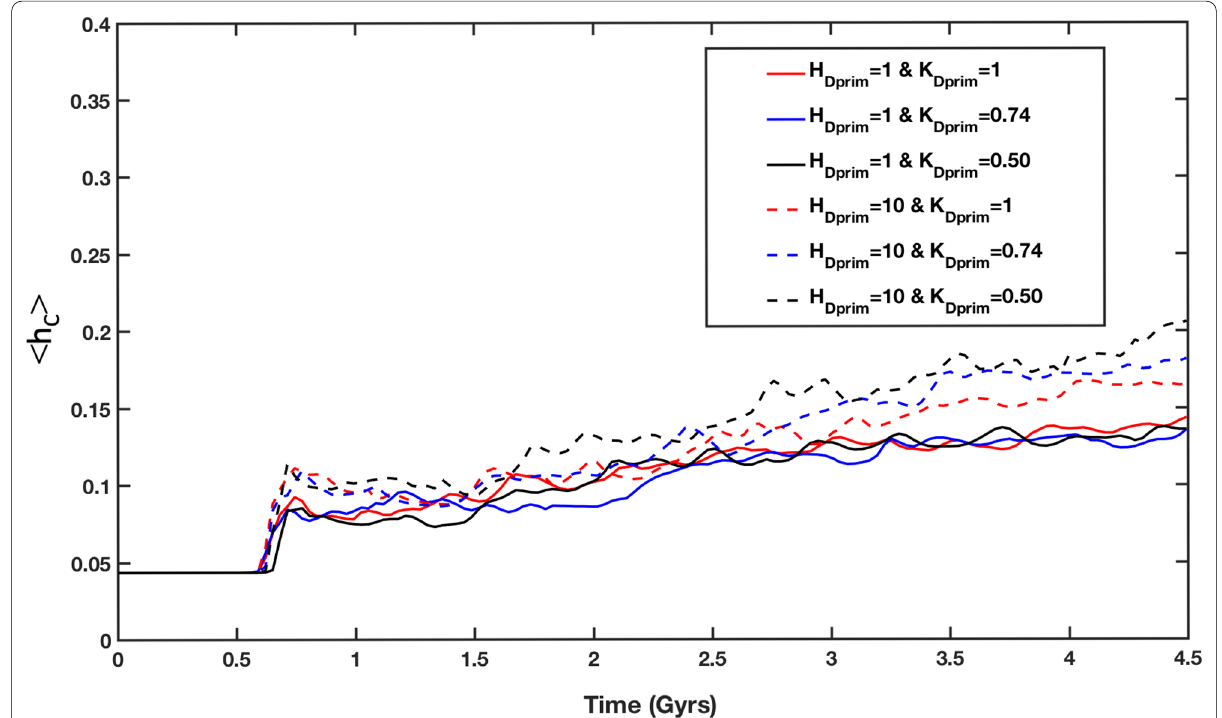
Fig. 4 Average altitudes of primordial material as a function of time for all